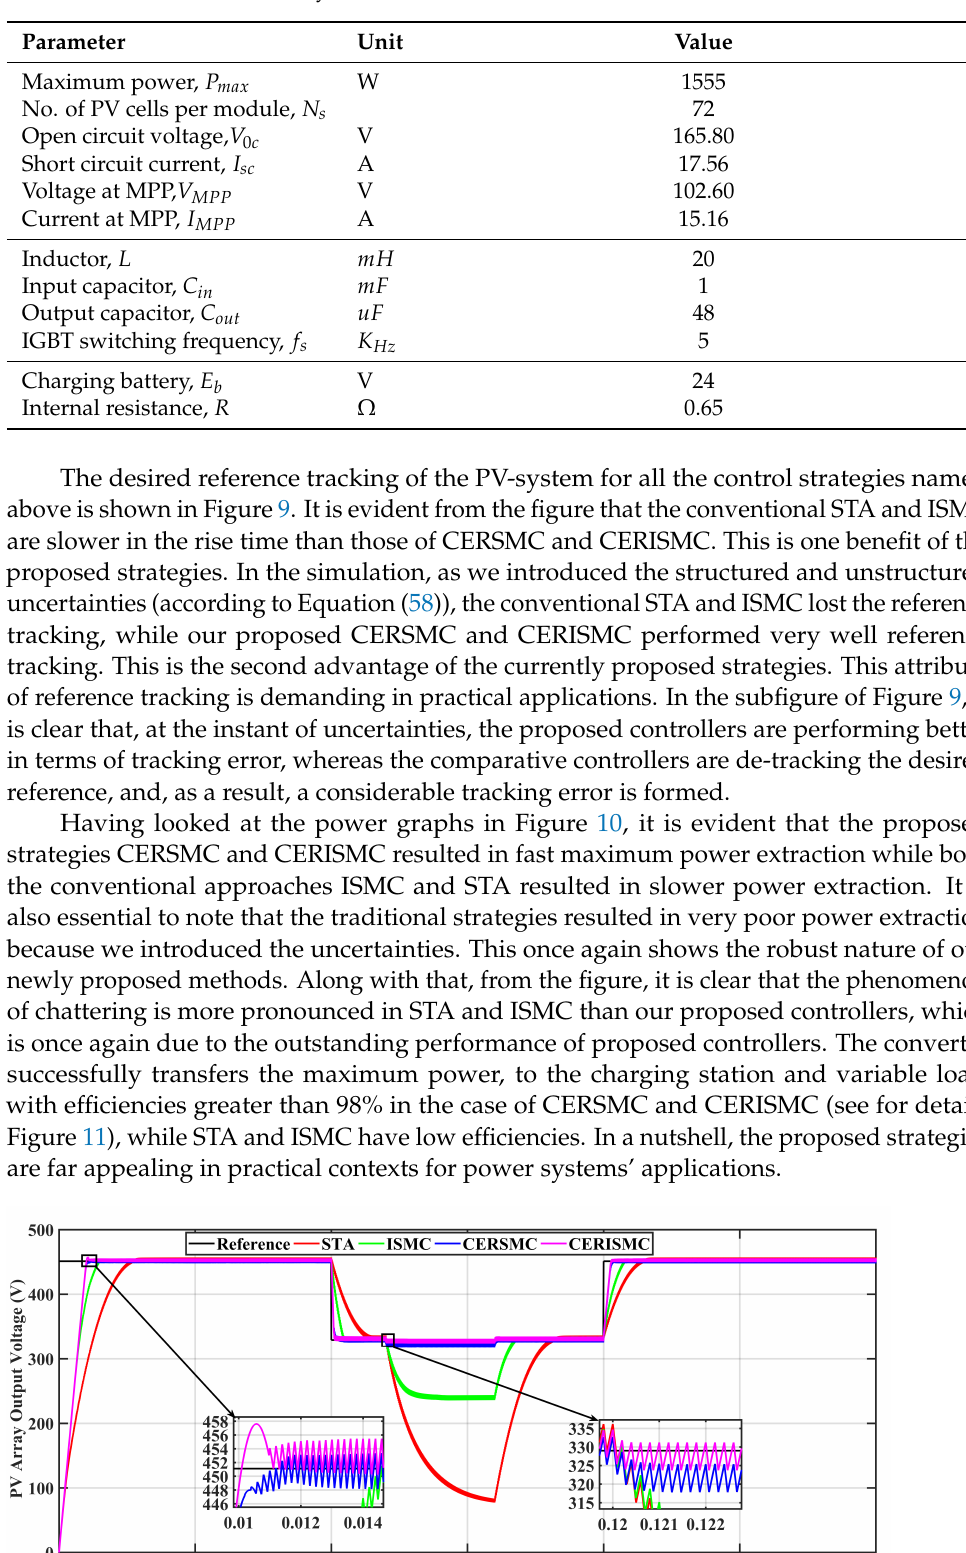
Table 1. Parameters of the PV system.